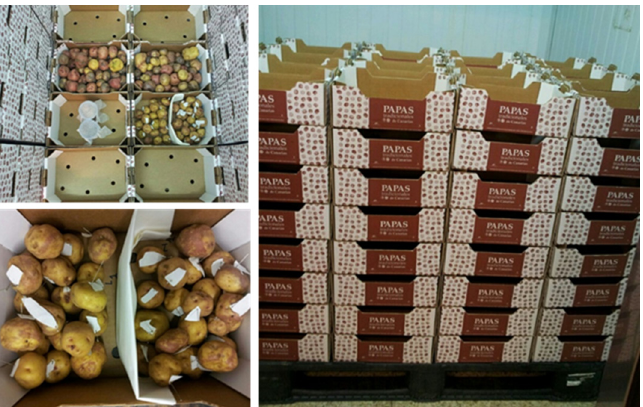
Figure 1. Semi-commercial trial. Pallet preparation using inoculated potatoes with eggs and larvae, pupae and adults in cylindrical vases, and one box of healthy and another of infested potatoes classified by the farmer. Photos: M.G. Lobo.